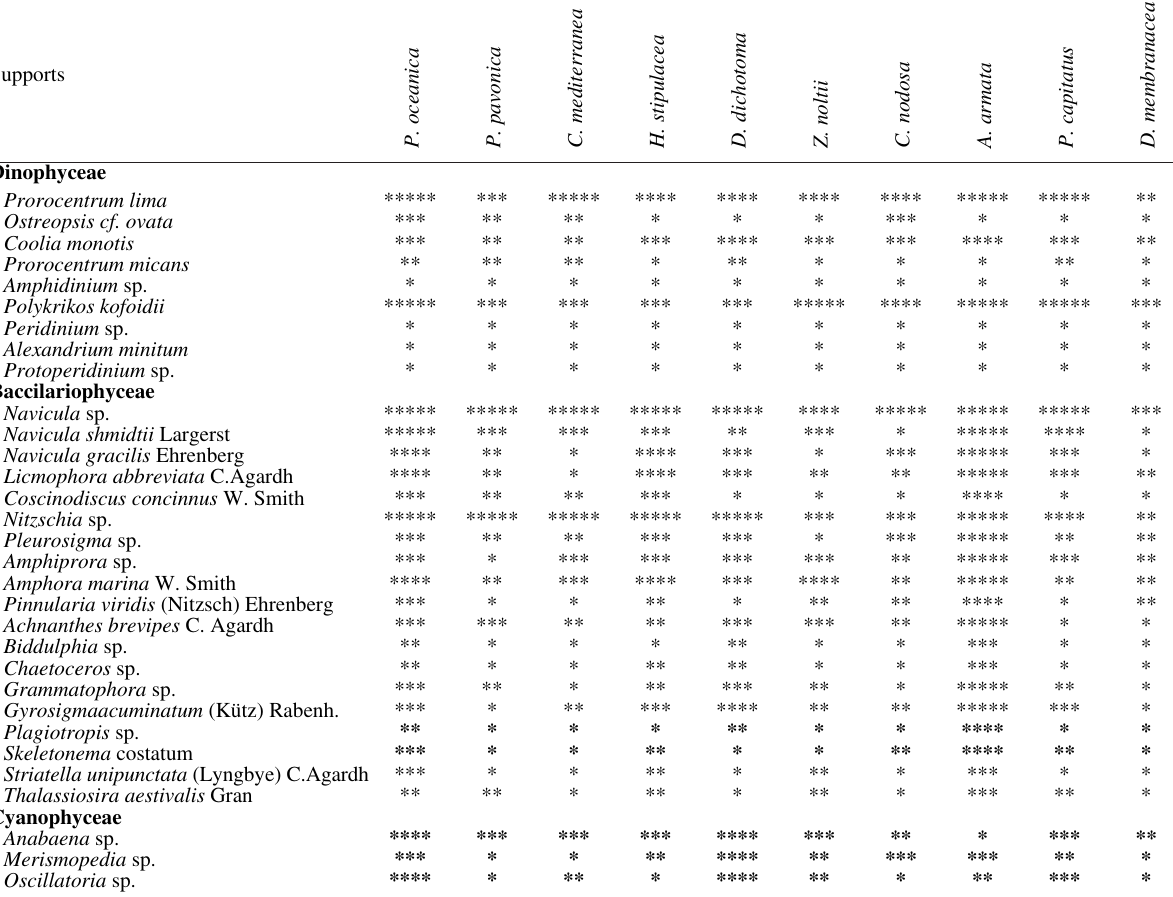
Table 2. – List of the counted species and the mean abundance (ind. g –1 FW) of microepiphytes in the locality of Chebba (*, 0; **, <100; ***, 101-500; ****, 501-1000; *****, >1000).